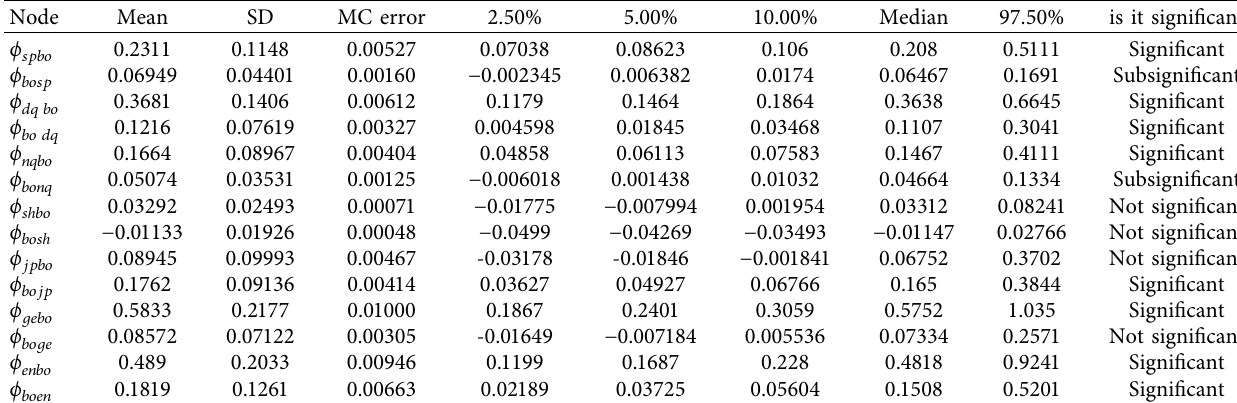
Table 7: Granger causality result between oil and stock